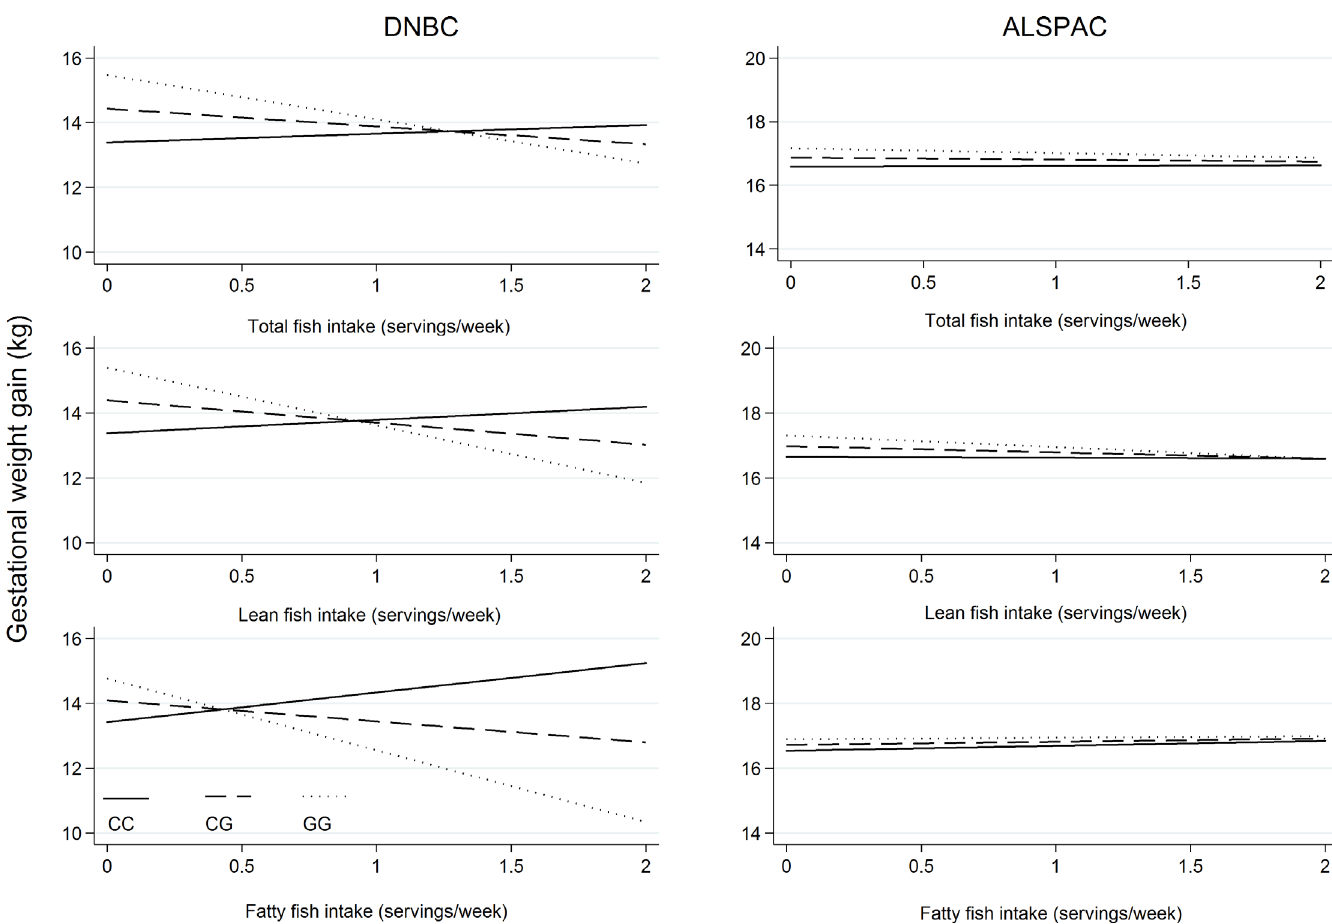
Fig 1. Interaction between PPARG rs1801282 and dietary fish in relation to gestational weight gain in the DNBC and ALSPAC. Adjusted for pre- pregnancy BMI, maternal age at conception, gestational age at birth, parity, social-occupational status, physical activity, smoking and alcohol intake during